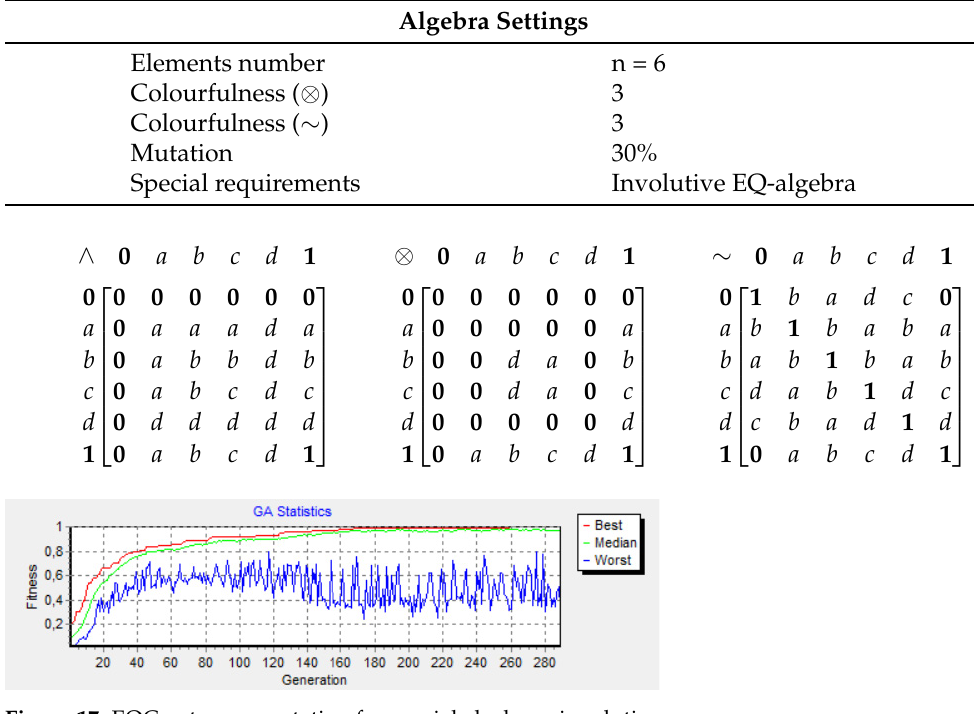
Figure 17. EQCreator computation for special algebra—involutive.